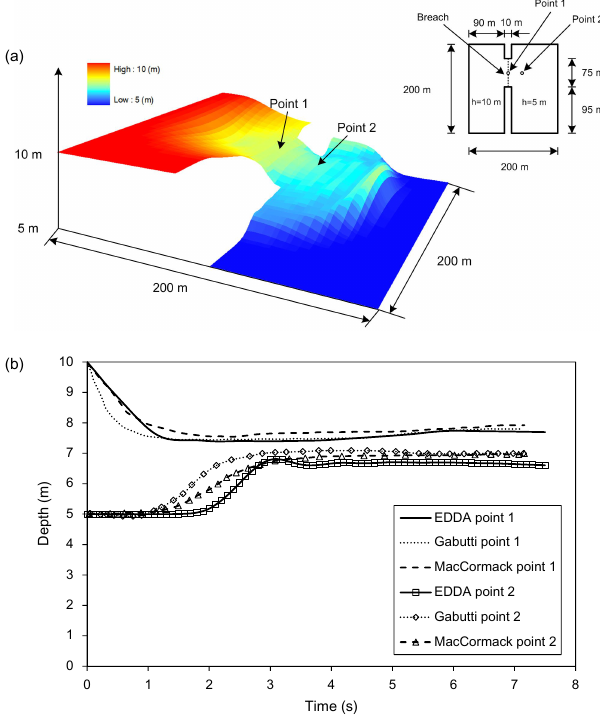
Figure 8. Numerical solutions in Test 2: (a) water depth at 7.1s after the dam breaches computed by EDDA; (b) comparison of the computed water depths at selected points using EDDA developed in this study and two numerical schemes reported by Fennema and Hanif Chaudhry (1987).